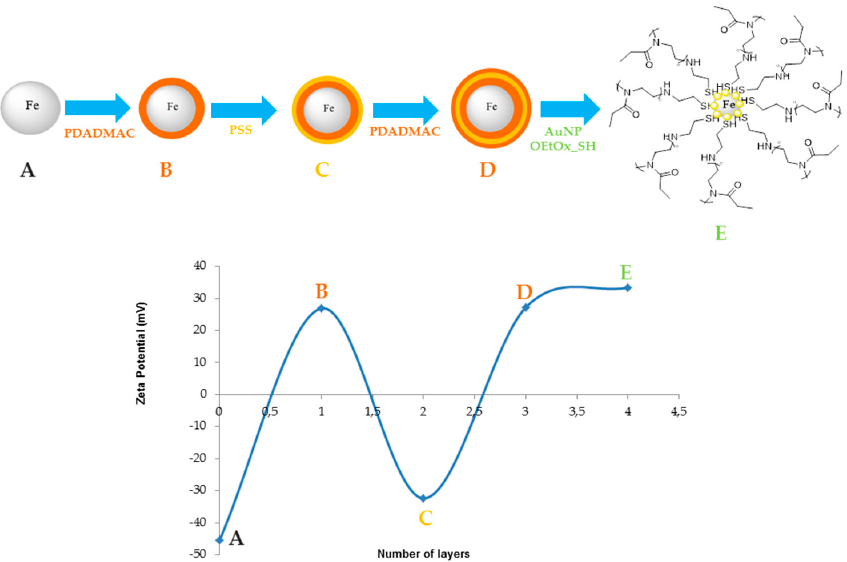
Figure 2. Zeta potential of the different layers, where the fourth layer corresponds to the final nanoparticles. PDADMAC—poly-diallyldimethylammonium chloride; PSS—poly-sodium 4-tyrenesulfonate.